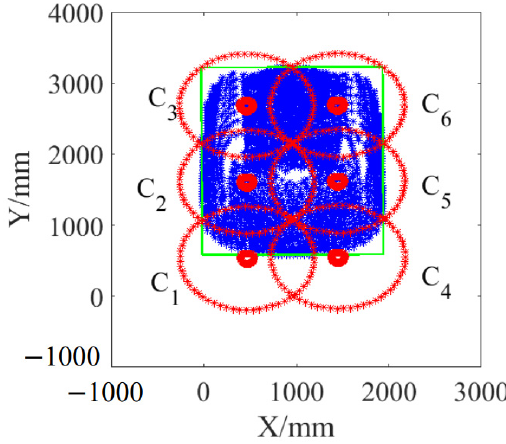
maximum processing area and the non-recommended processing area of the UR5 robot. C 1 represents the coordinates of the i-th circle, and the coordinates of C i are shown in Table 2.